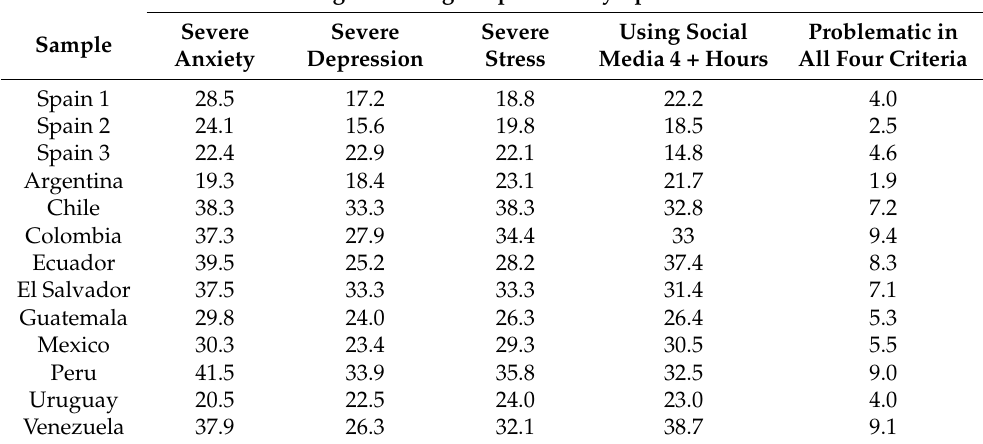
Table 4. Five profiles of problematic youth: potential criteria for the definition of a true condition for ‘addictive’ smartphone